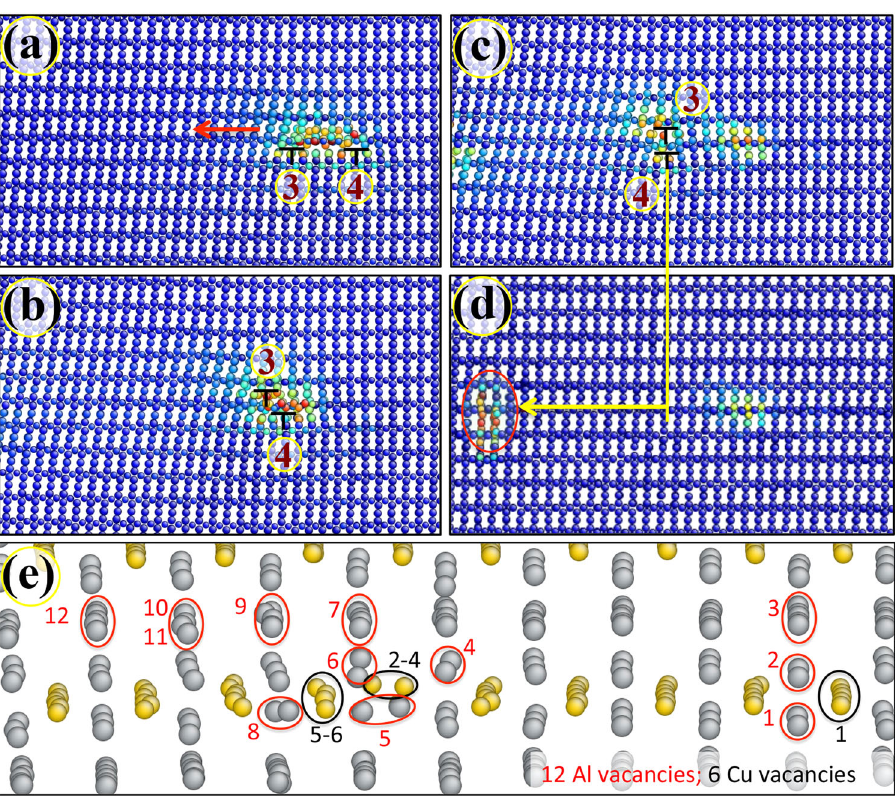
Fig. 4 Four snapshots show atomic structure of a full dislocation during climb and collective glide. a One full dislocation dissociated into two partials 3 and 4; b One partial 3 climbs for four atomic planes associated with the creation of vacancies in dislocation core; c A vertical- extended dislocation with the vertical separation of four atomic plane; and d The vertical-extended dislocation de-pins from the environment of vacancies, and collectively glide for a distance of d without the creation of stacking fault. e Atomic structure shows the creation of 18 vacancies before the collective glide. Yellow atoms are Cu and gray atoms are Al. The circle indicates location of the ith vacancy. The symbol “ ⊥ ” indicates the position of